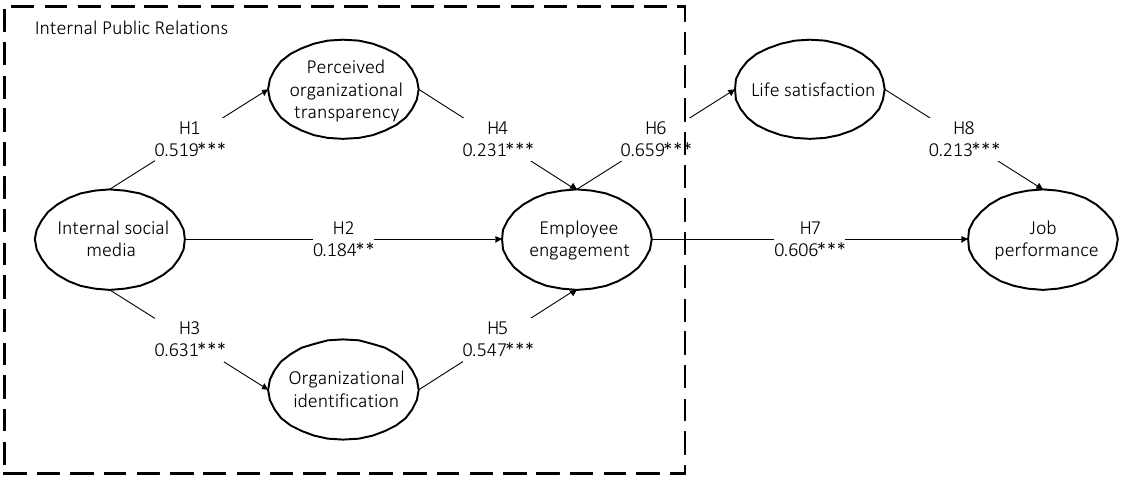
Figure 2. Results of hypothesis